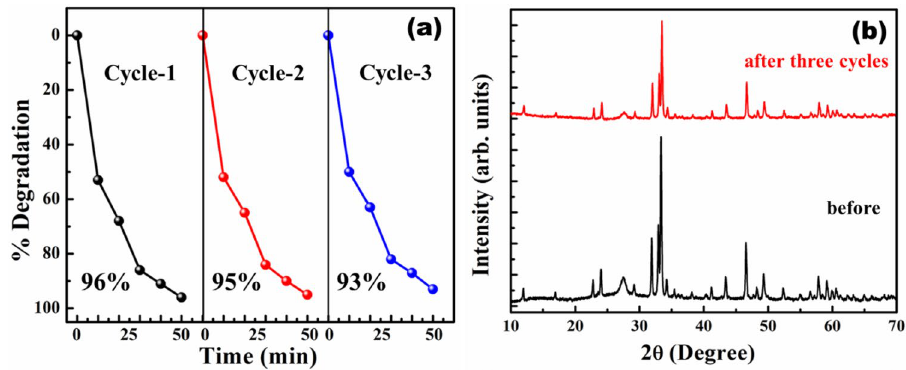
Figure 8. ( a ) The cyclic photocatalytic experiments for the degradation of MB using CCN50 ( b ) XRD patterns of CCN50 before, after the 3-cycles of photocatalytic degradation of MB.